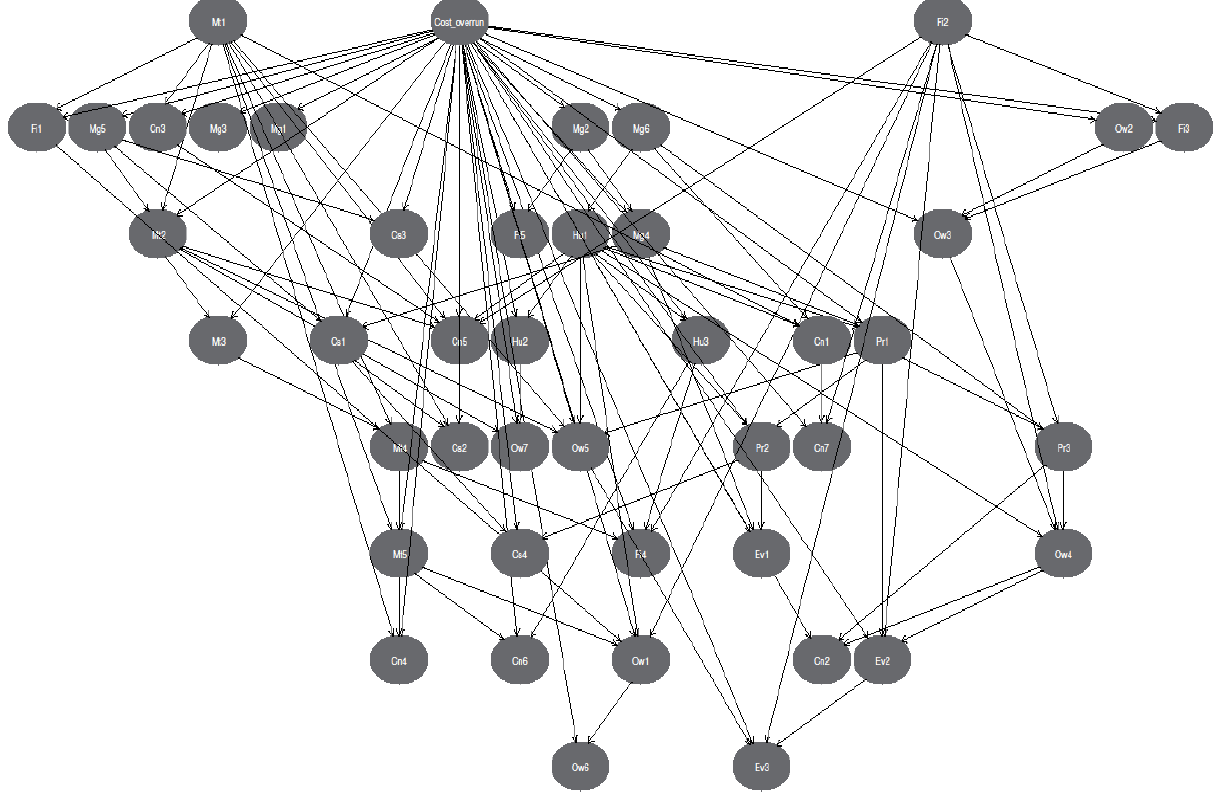
Figure 4. K2GN-Un learned network.